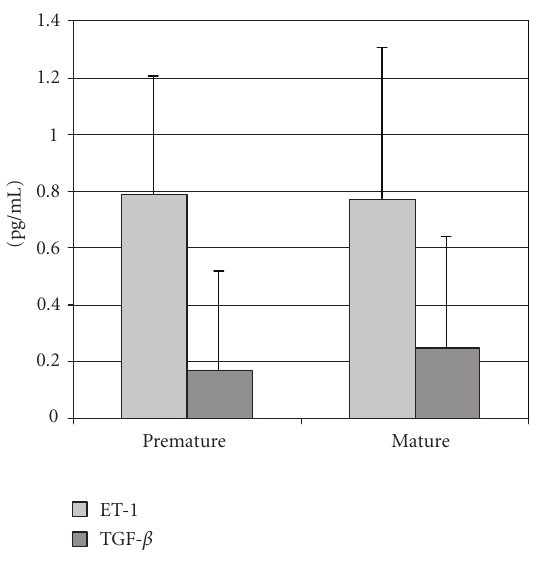
Figure 1: Plasma ET-1 concentrations of the healthy premature and mature newborns were 0 . 79 ± 0 . 44 and 0 . 77 ± 0 . 56pg/mL, respec- tively. This di ff erence was not significant ( P > . 05). Also TGF- β con- centrations in this group were 0 . 17 ± 0 . 37 and 0 . 25 ± 0 . 41pg/mL, respectively, and was not significantly di ff erent ( P > . 05).